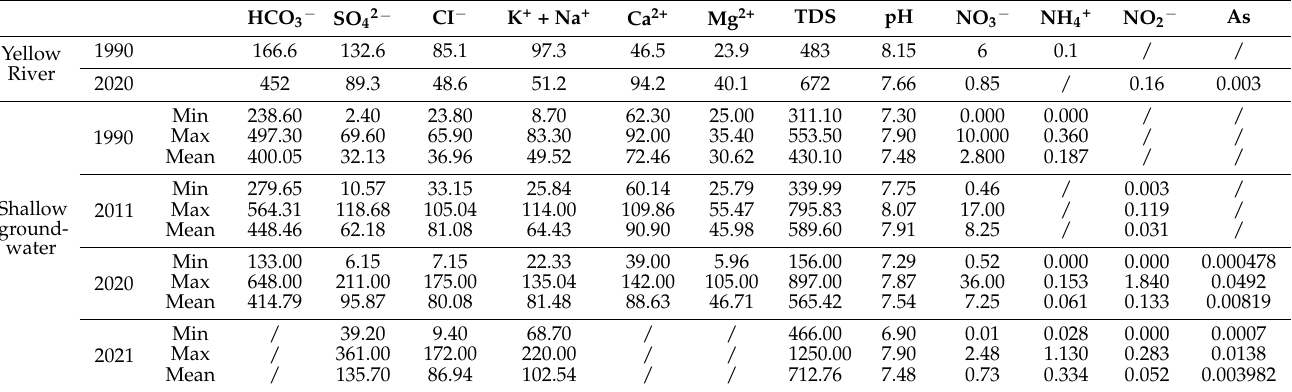
Table 1. Statistical analysis table of hydrochemical characteristics of sampling